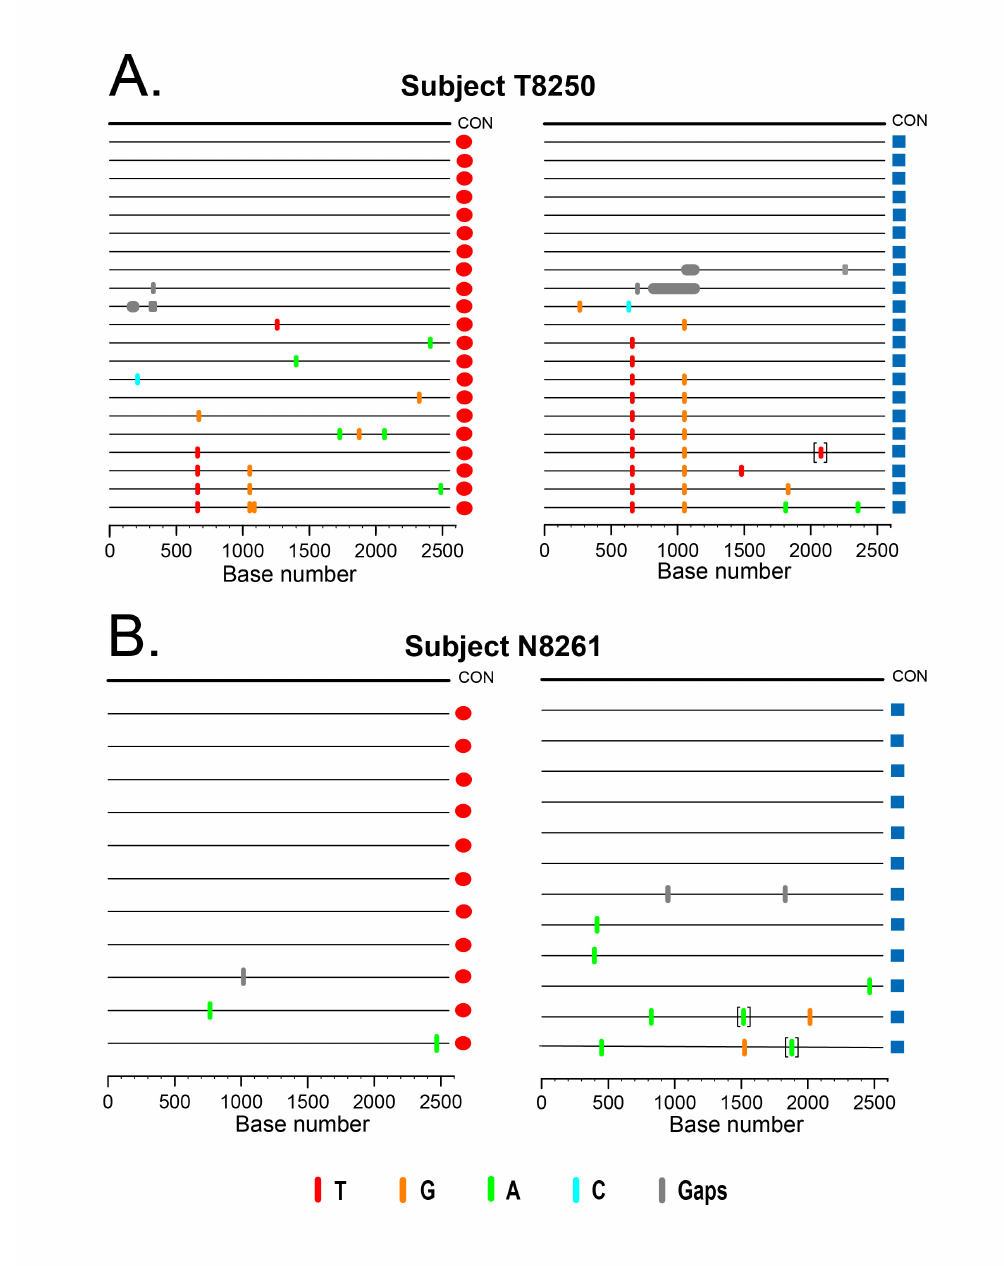
Figure 2. HIV-1 env sequences from paired DBS-plasma samples coalesce to a common ancestor in two acutely infected subjects. Highlighter plots of gp160 env sequences derived from DBS (red circles) or plasma (blue squares) from subjects T8250 (A) and N8261 (B) exhibit low genetic diversity and coalesce to identical TF env sequences for each subject. In T8250, shared polymorphisms occur at the same two nucle- otide positions in both DBS and plasma sequences. Nucleotide differences from the inferred consensus se- quence are indicated by tic marks color-coded for each base or gaps due to nucleotide deletions; tics inside brackets indicate nucleotide insertions. The horizontal axis indicates HXB2 env nucleotide